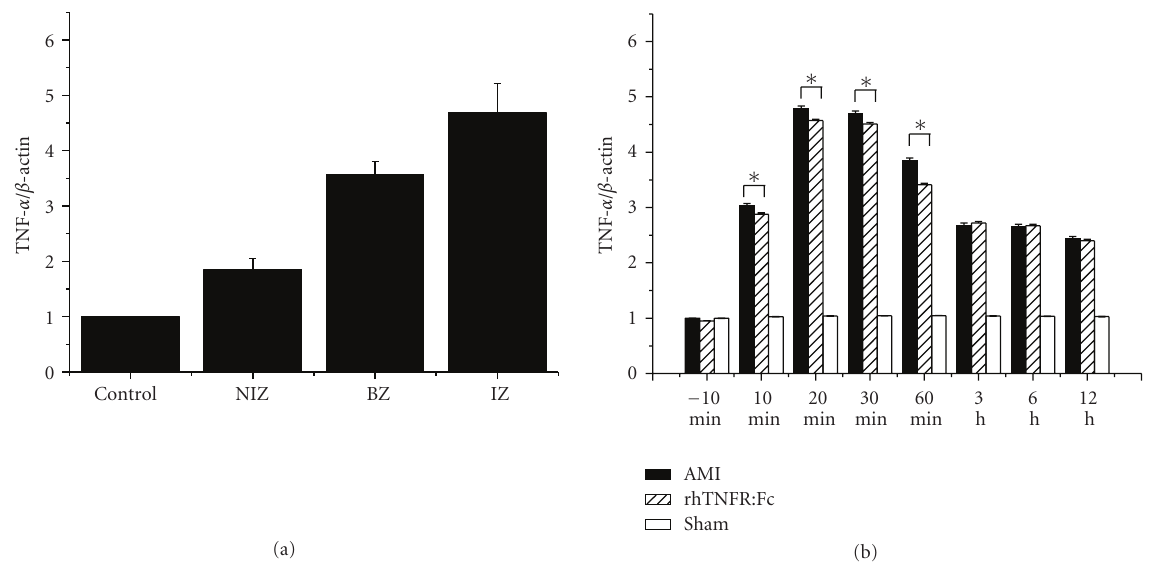
Figure 2: Expression of TNF- α mRNA detected by real-time fluorescent quantitative PCR. (a) Expression of TNF- α mRNA in the non- ischemia zone, the border zone, and the ischemic zone of AMI group; (b) expression of TNF- α mRNA among the di ff erent groups. AMI or rhTNFR:Fc group versus sham-operation group, ∗ P < . 05.